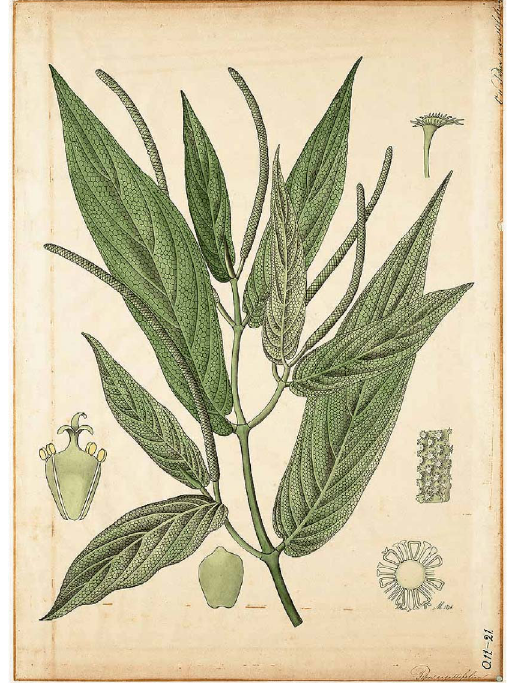
Figure 1. Piper aduncum L. (from Botanischen Wandplatet at